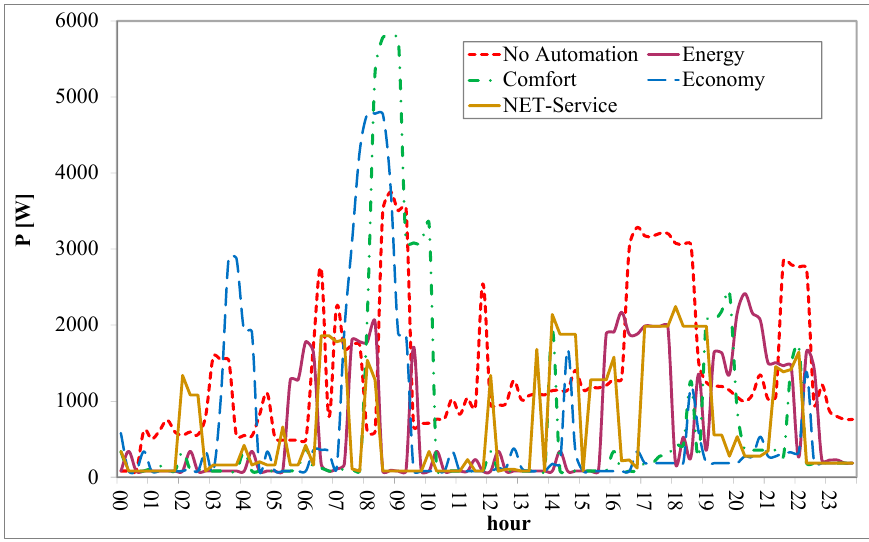
Figure 1. Daily power profiles for an apartment, modified by the action of the control logics. Table 2. Electric loads in the apartment.